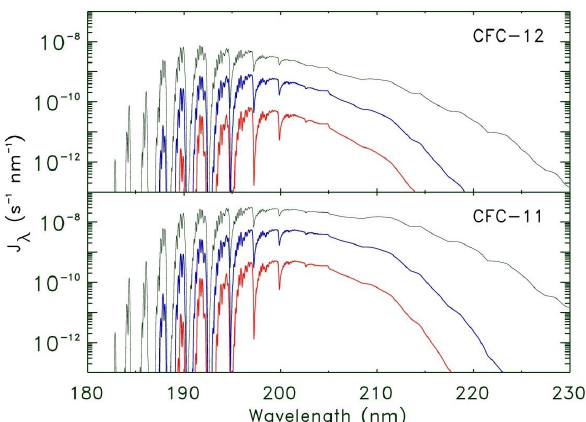
Fig. 2. Spectrally resolved contributions to the photolysis rates for CFC-12 (top) and CFC-11 (bottom) plotted for pressures of 6 hPa (black), 20 hPa (blue), and 60 hPa (red) calculated for the tropical stratosphere using March climatological temperatures and ozone (see text for details) and a solar zenith angle of 30 o . Spectral J-values below 200 nm have been smoothed at 0.1-nm full width half maximum for clarity of presentation.